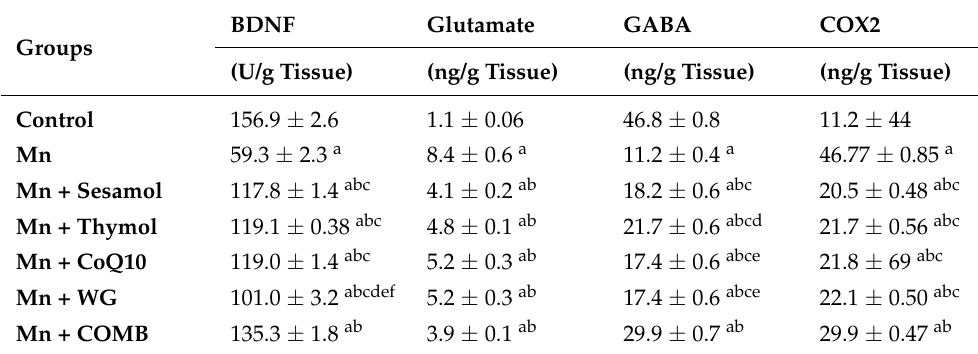
Table 2. Effect of sesamol, thymol, CoQ10, WG, or their combination on MnCl 2 -induced changes in brain BDNF, GABA, glutamate, and COX-2 levels.